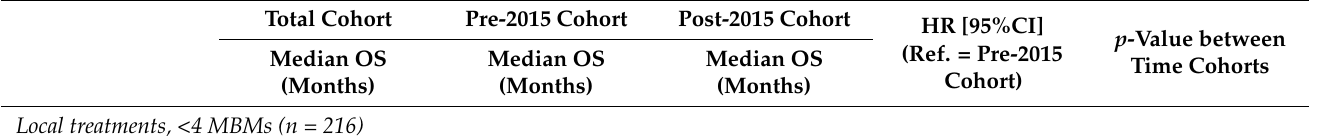
Table A3. Overall survival (OS) for local treatment directly after MBM diagnosis, in patients with <4 melanoma brain metastases (MBMs) in the total cohort ( n = 216), pre-2015 cohort ( n = 75) and post-2015 cohort ( n = 141).